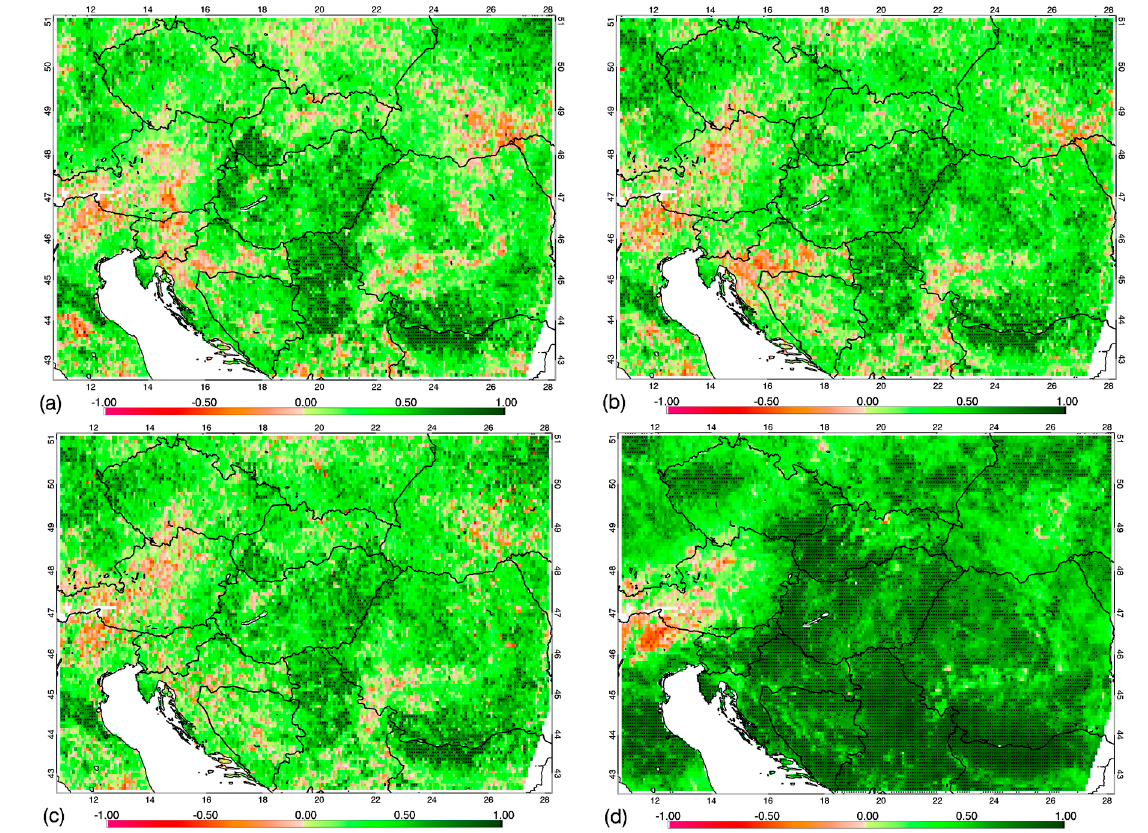
Figure 10. Map of R values between the precipitation anomaly in August and the NDVI anomaly in September derived from ( a ) the NDVI3g O ; ( b ) NDVI3g F ; ( c ) NDVI3g H and ( d ) NDVI MODIS datasets. Pixels with dots inside indicate statistically significant R (p < 0.01).